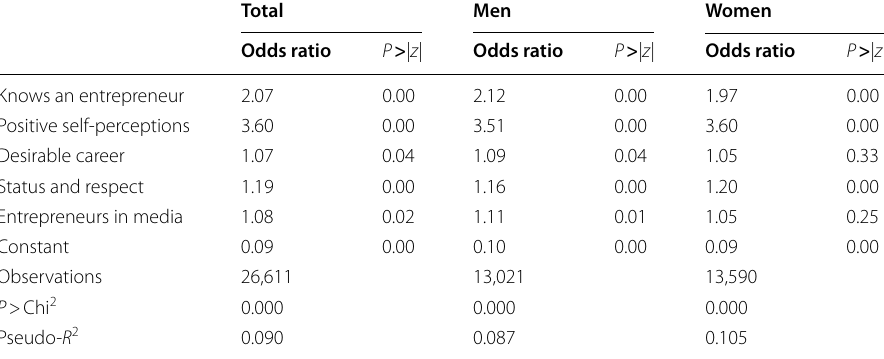
Table 2 Total and gender